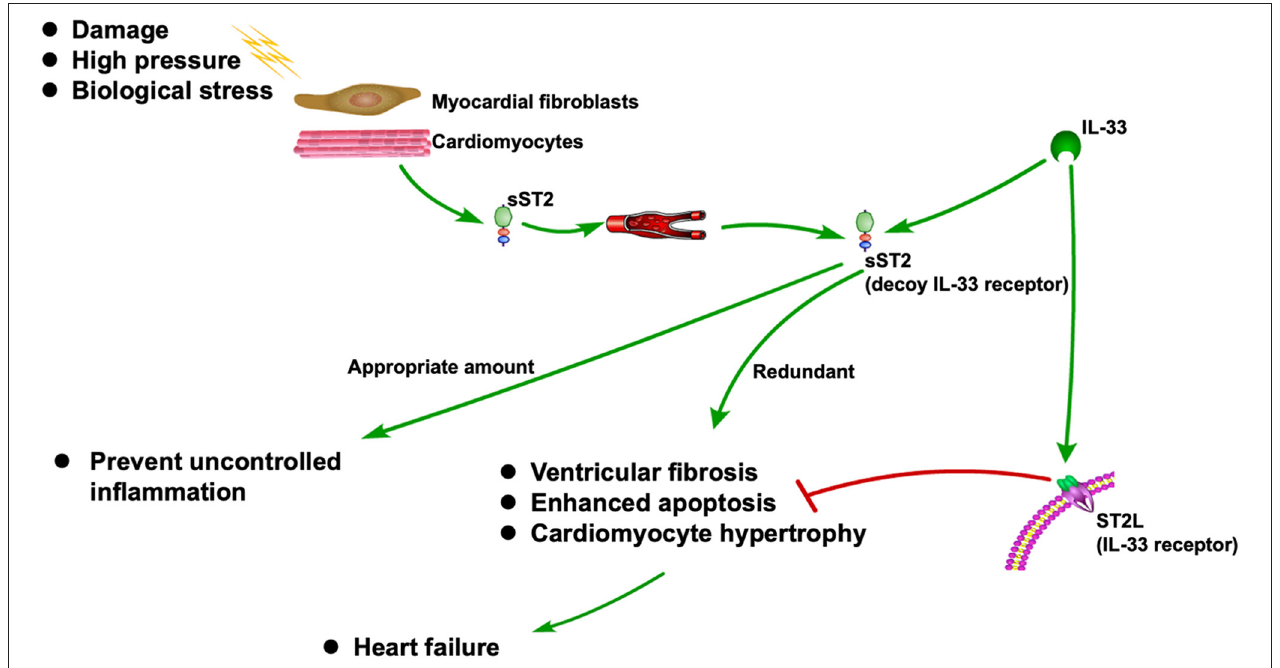
FIGURE 1 | ST2 pathway in